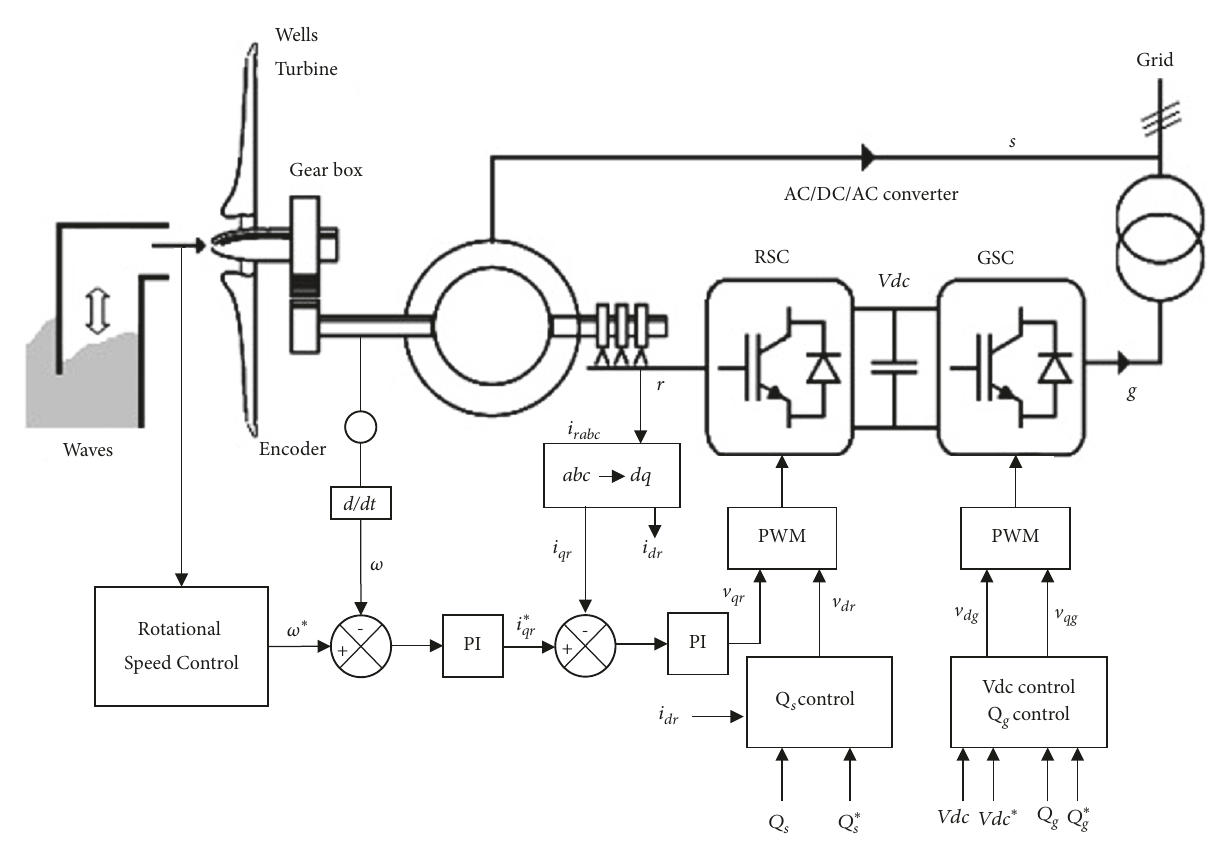
Figure 3: DFIG control strategy